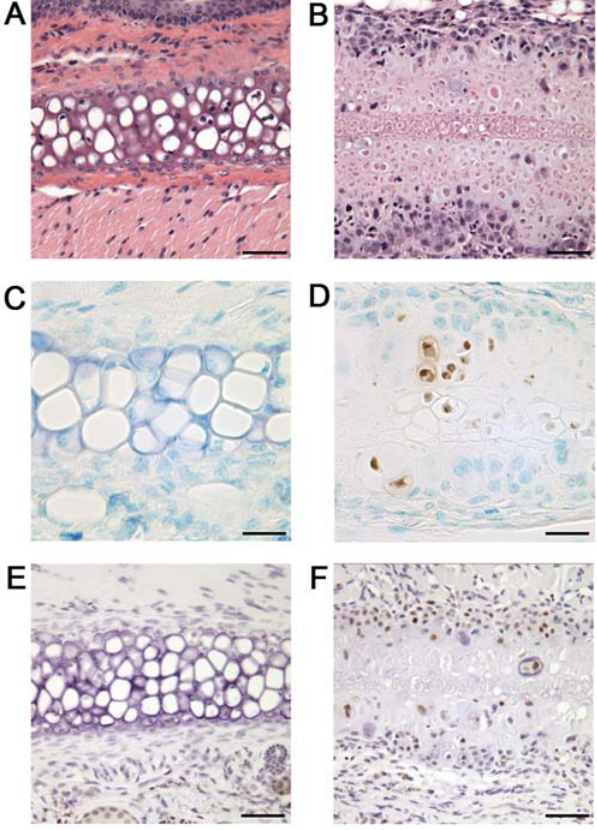
Figure 5. Auricular chondronecrosis and hypoplasia in Trsp fl/fl Col2a1-Cre mice. (A) Hematoxylin and eosin staining of ear cartilage from a control Trsp fl/fl mouse, compared with (B) Trsp fl/fl Col2a1-Cre auricular cartilage that shows a wide band of necrotic chondrocytes. Detection of TUNEL positive cells (stained brown, with methyl-green counterstain) in Trsp fl/fl control (C) and Trsp fl/fl Col2a1-Cre (D) auricular cartilage. Note abundance of necrotic cells with scattered TUNEL positive cells in (D). Evidence of apparent regenerative activity of cartilage above and below the band of necrotic cartilage, but not in the control (E), is shown (F). Detection of cell proliferation using anti-PCNA antibody immunostaining on control Trsp fl/fl (E) and Trsp fl/fl Col2a1-Cre (F) cartilage; haematoxylin counter stain. Scale bars are as follows: 55 m m (A,B,E,F), 27 m m (C,D).